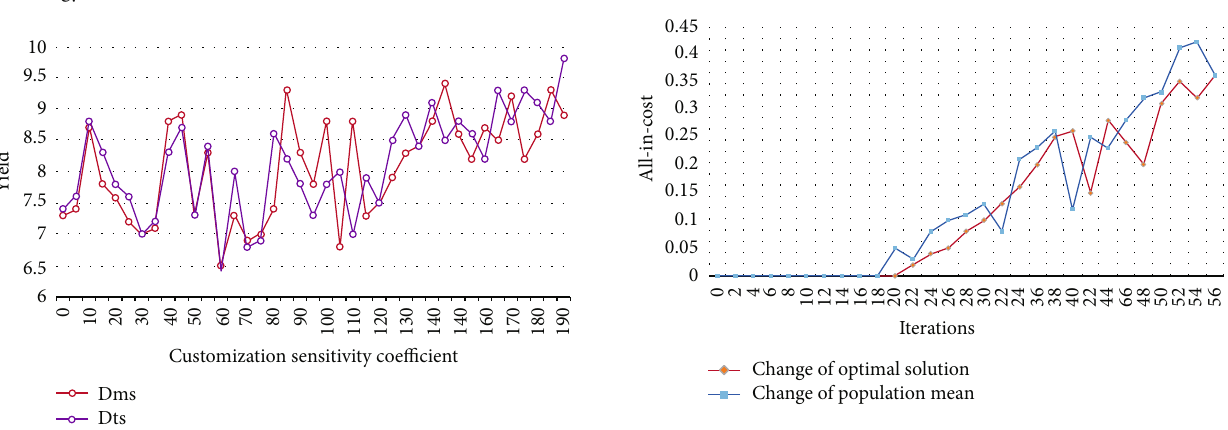
Figure 6: The in fl uence of customer customization sensitivity coe ffi cient on price under the SC of 3D image processing technology.